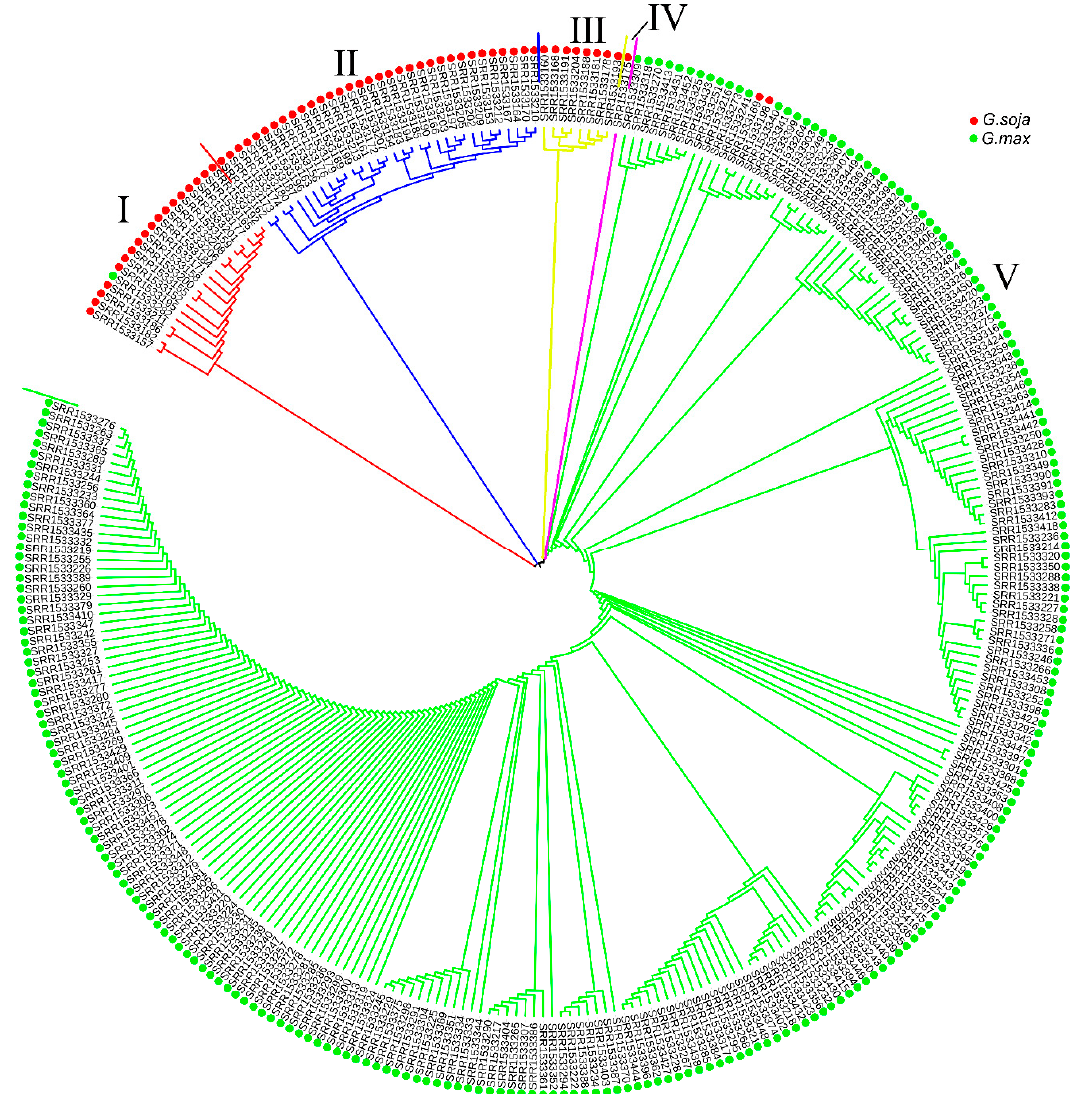
Figure 7. Phylogenetic tree of 302 accessions. SNPs of the 10 selected genes among resequenced genomes of the 302 soybean accessions were used to construct the neighbor-joining (N-J) phylogenetic tree. The bootstrap value was set as 1000 replicates. Corresponding specie idnetifiers (IDs) of the accessions are available from Reference [57] .